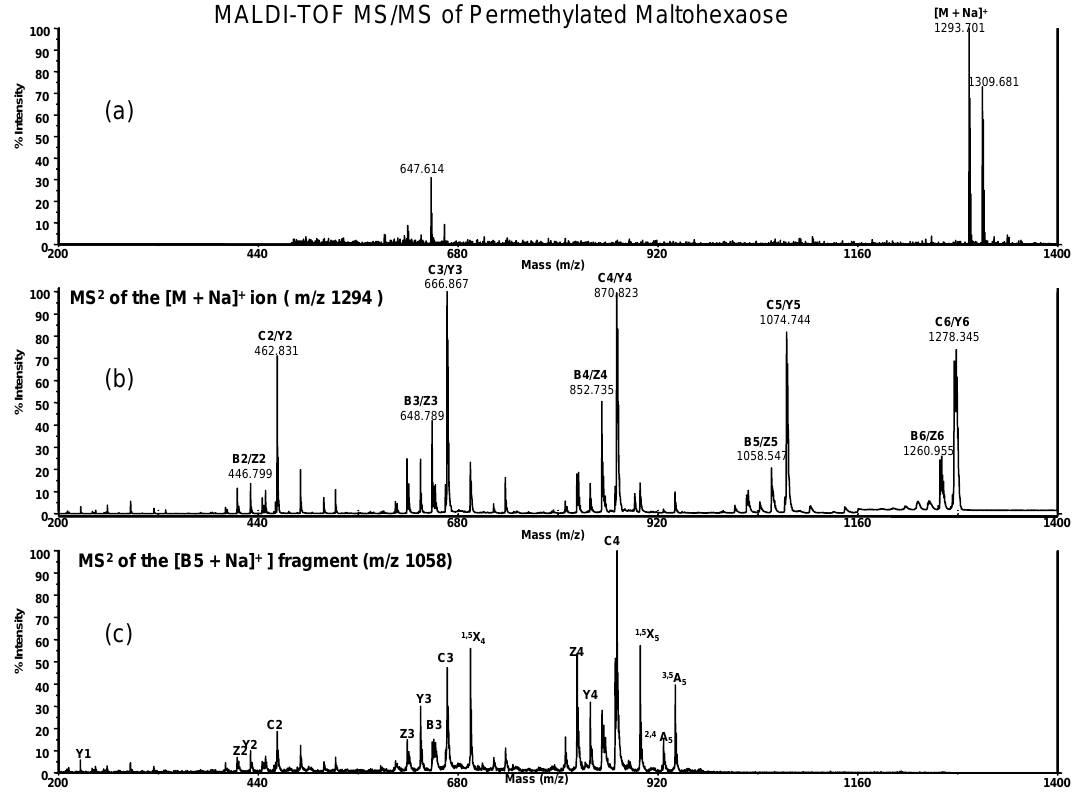
Figure 3 . MALDI-TOF MS/MS of permethylated maltohexaose in 2,5-DHB as matrix. The ion of maltohexaose ( m/z = 1293.8, [M + Na] + ) shown in figure 3a. MS 2 at the permethylated maltohexaose ion ([M + Na] + , m/z = 1293.8) shown in 3b and MS 2 at the sodiated fragment ion ( m/z = 1058.8) shown in figure 3c. The major cross-ring B 5 fragment ions at B ~C region ( m/z = 1058.8 ~ 870.8) are 941.0 ( 3,5 A 5 4 898.9 ( 1,5 X 5